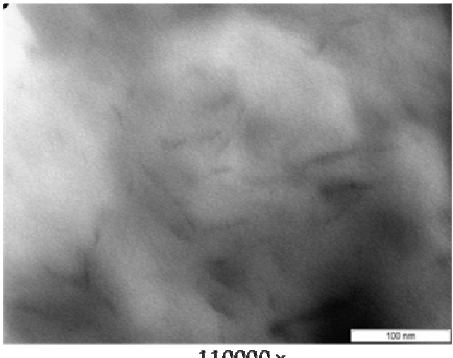
Photomicrographs of the systems PA6/MMT (Figure 3), PA 6/OMMT-Gen (Figure 5) and